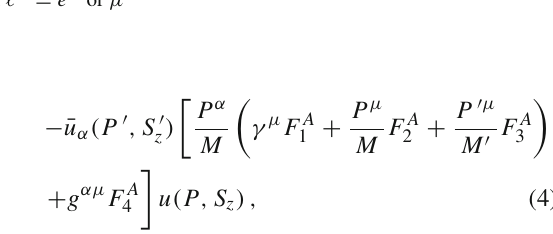
Fig. 1 Feynman diagrams for a (cid:2) 0 c → (cid:2) − π + (ρ + ) and b (cid:2) 0 c → (cid:2) − (cid:10) + ν (cid:10) with (cid:10) + = e + or μ